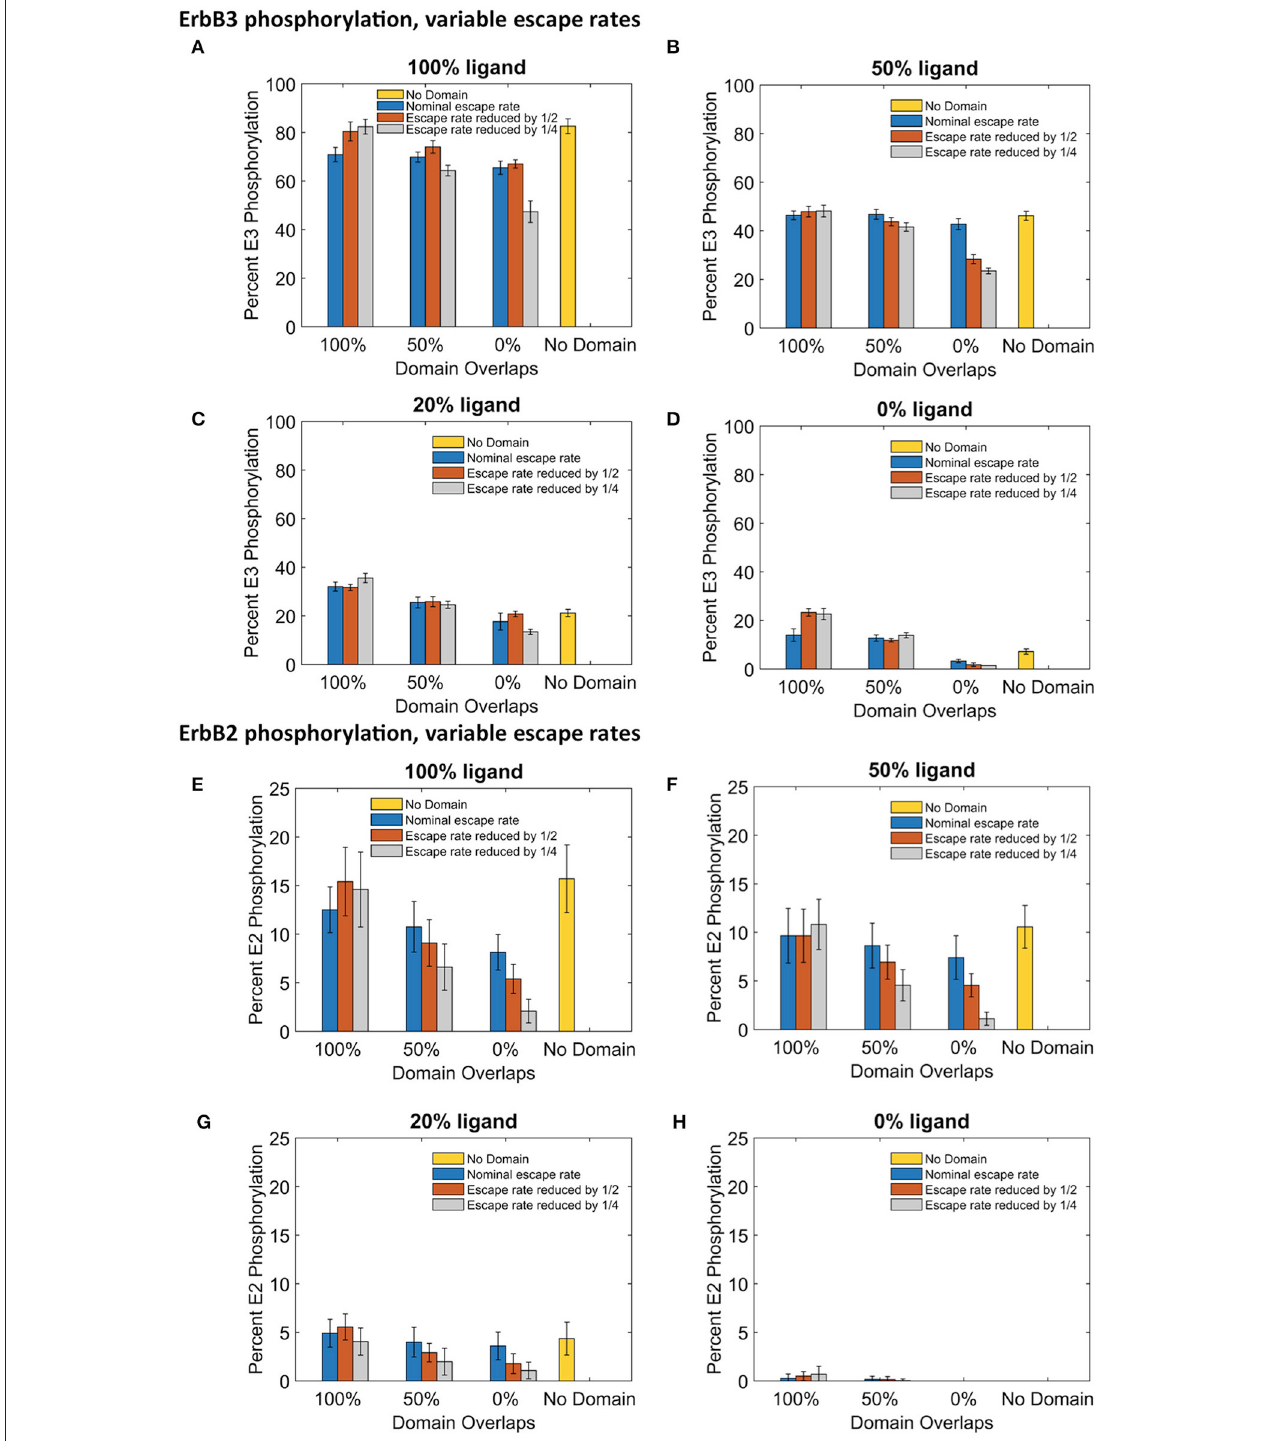
FIGURE 6 | The effect of changes in domain retention on ErbB3 and ErbB2 phosphorylation across different ligand concentration and domains. Total receptor phosphorylation across different membrane configurations, ligand concentration and three different escape rates- nominal escape rate (blue bars), escape rate reduced by ½ (orange bars), and escape rate reduced by ½ (gray bars) as well as no domain simulations (yellow bars). (A) Total ErbB3 phosphorylation for 100% liganded ErbB3. (B) Total ErbB3 phosphorylation for 50% liganded ErbB3. (C) Total ErbB3 phosphorylation for 20% liganded ErbB3. (D) Total ErbB3 phosphorylation for 0% liganded ErbB3. (E) Total ErbB2 phosphorylation for 100% liganded ErbB3. (F) Total ErbB2 phosphorylation for 50% liganded ErbB3. (G) Total ErbB2 phosphorylation for 20% liganded ErbB3. (H) Total ErbB2 phosphorylation for 0% liganded ErbB3. All bars are the averages of 4 runs ± standard deviation.